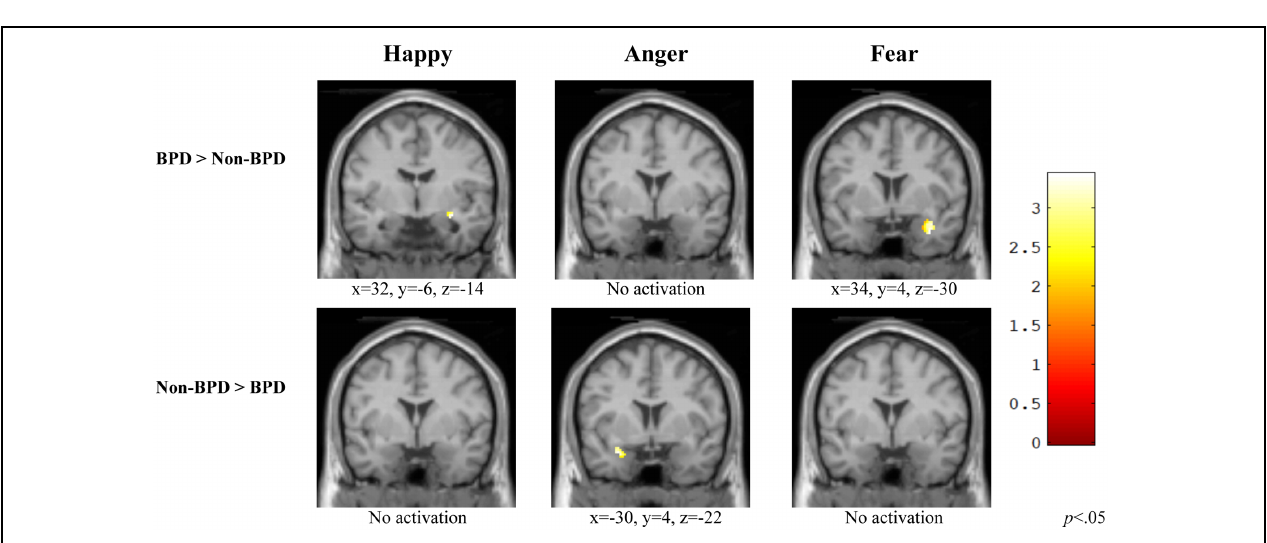
FIGURE 4 | Group comparisons of Amygdala ROI activity in three affective categories. Within the amygdalar ROI, individuals diagnosed with BPD exhibited greater activation while viewing happy and fear versus neutral faces, but not while viewing anger versus neutral and had a differential pattern of activation overall relative to those without BPD. BPD, borderline personality disorder; Non-BPD, No